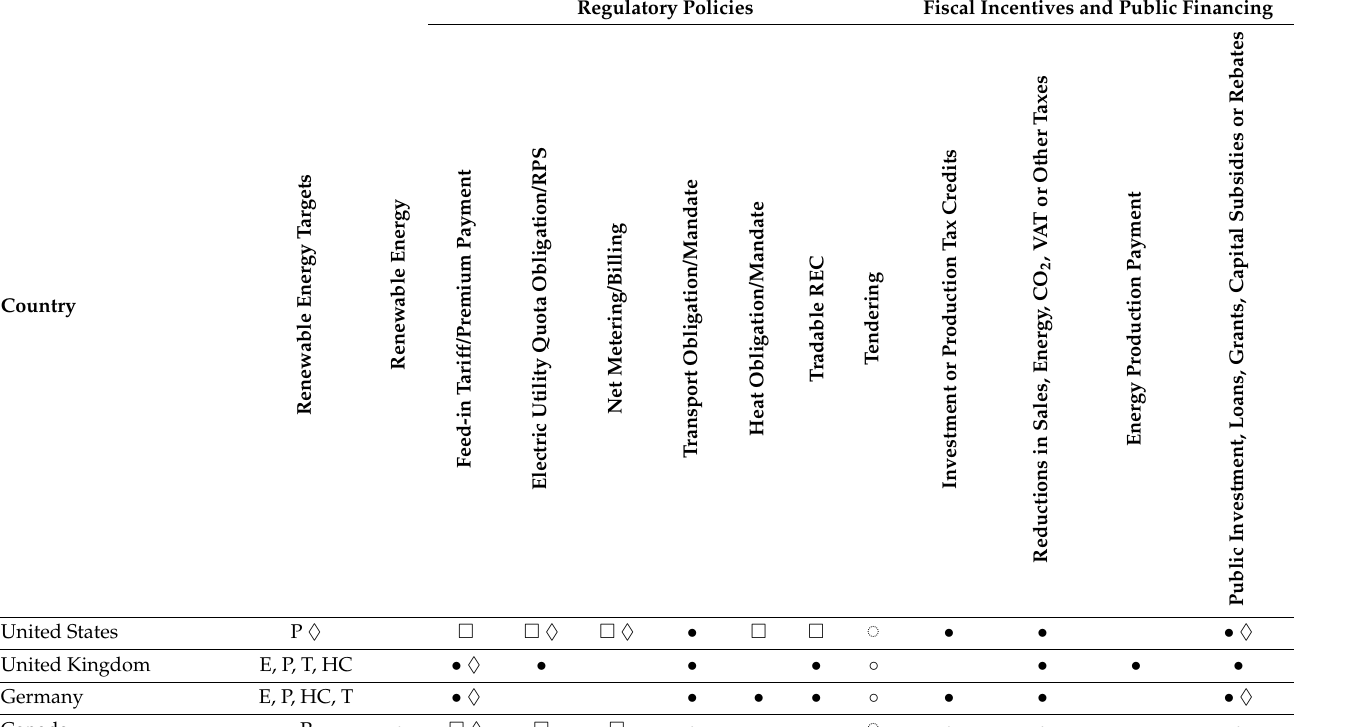
Table 1. RE policies in different countries including KSA—comparative analysis.